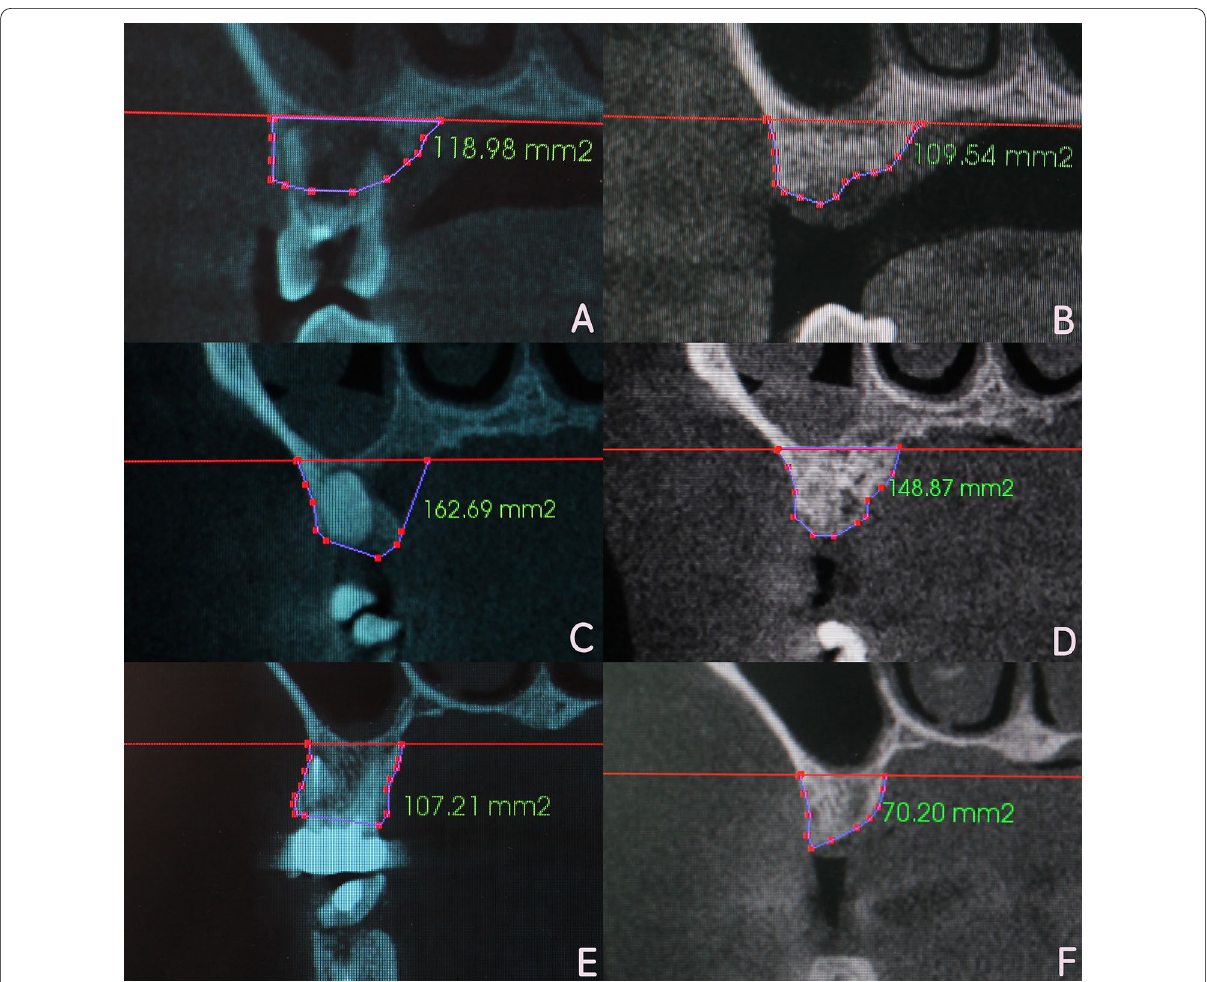
Fig. 3 CBCT imaging observation and measurement for the three groups preoperatively and 8 months postoperatively. a Preoperative image for CGFs/DBBM group; b 8 months postoperatively in CGFs/DBBM group; c preoperative image for DBBM group; d 8 months postoperatively in DBBM group; e preoperative image for control group; f 8 months postoperatively in control